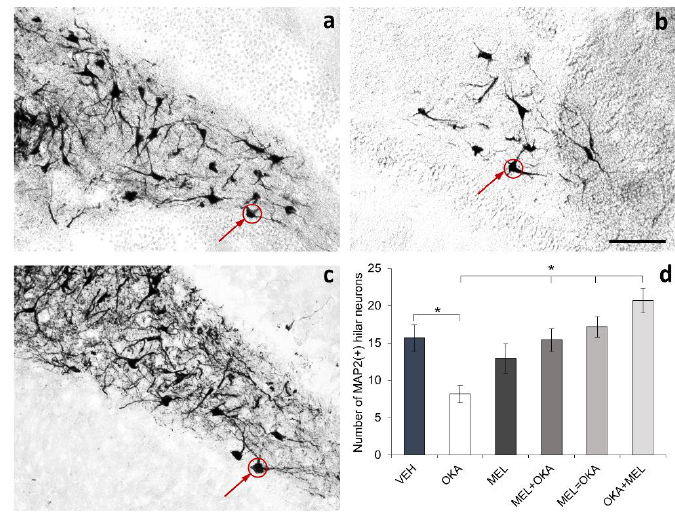
Figure 4. E ff ect of okadaic acid and melatonin on the number of neurons in hilar hippocampus. Rat hippocampal organotypic cultures (400 µm) were treated at the 8th day for 6 or 8 h; afterwards, they were fixed as described in methods section and 50 µm cryosections were processed for MAP2 staining by immunohistochemistry. Representative images of only three treatments are shown in the figure: ( a ) vehicle (VEH), ( b ) okadaic acid (OKA), and ( c ) simultaneous incubation with okadaic acid and melatonin (VEH = MEL). As MAP2 is distributed in the somatodendritic domain, the staining of this protein allowed us to detect neuronal somas shown with red circles and arrows. Fields were acquired randomly by treatment (4 fields/slice and 5 slices/treatment) and the total number of MAP2(+) cells at the hilus was counted and plotted in panel ( d ). Data represent the mean ± SEM and statistical analysis was performed with ANOVA on Ranks before Student-Newman-Keuls test for multiple comparisons. * represents p < 0.05. Scale bar in ( b ): 100 µm.